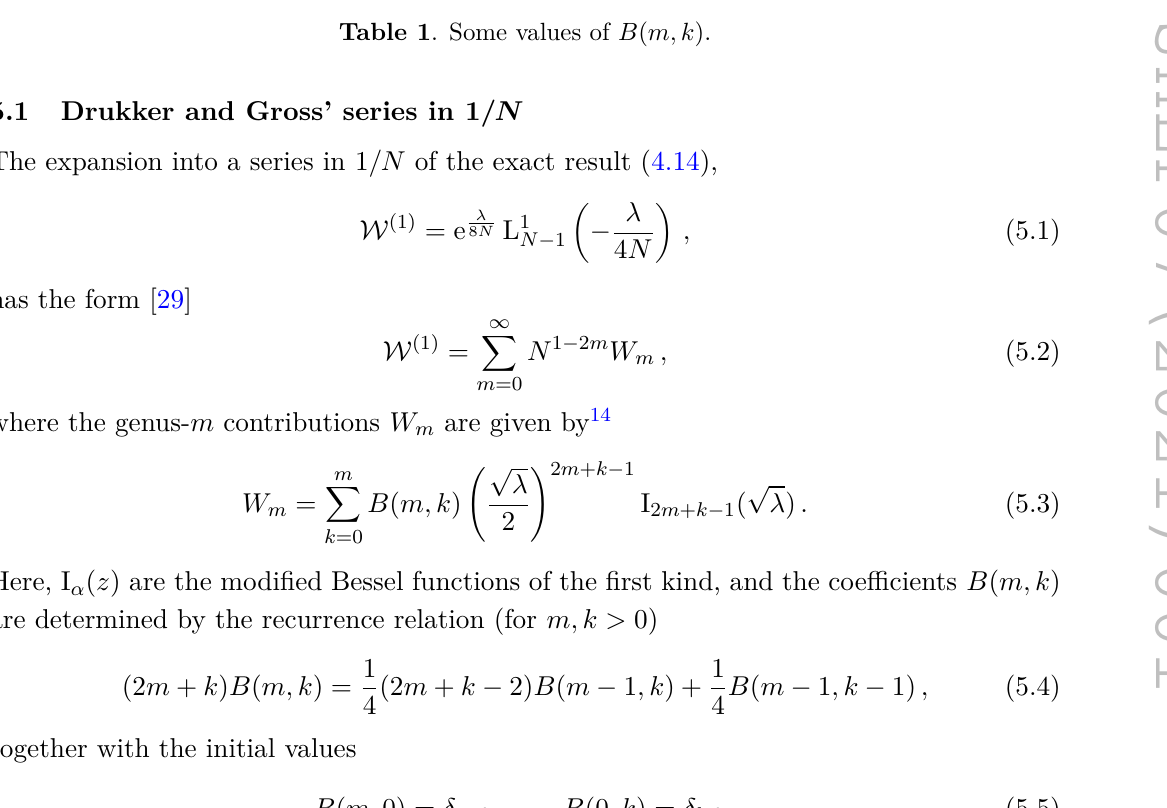
Table 1 . Some values of B ( m, k )